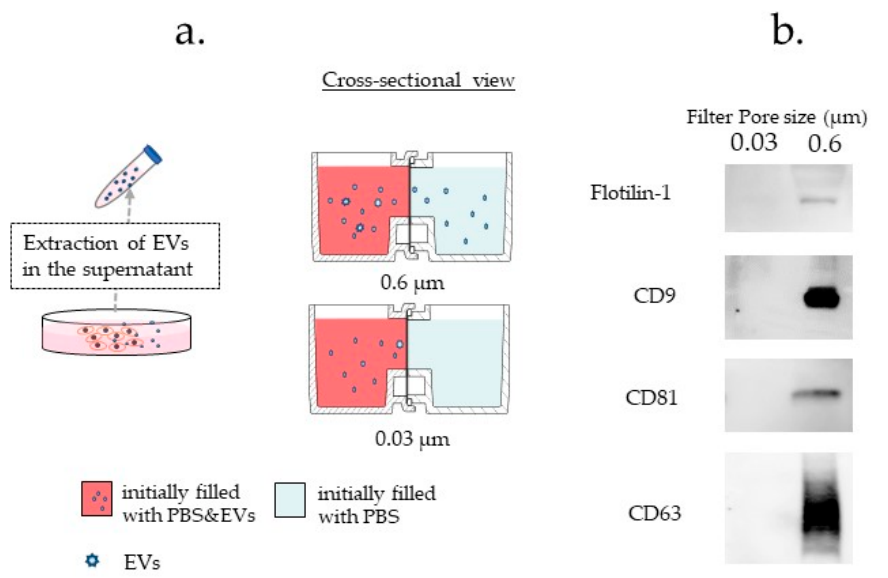
Figure 6. Validation of the ability of extracellular vesicles (EV) to pass through the filter according to pore size. ( a ) Scheme of the evaluation method for EVs secreted from PANC-1 cells. ( b ) Evaluation of the passing ability of extracellular vesicles (EVs). The same number of EVs from PANC-1 cells were seeded on one side (left side) of the horizontal-type co-culture plate (HTCP). The number of exosomes passing through the filter on the vessel’s right side were measured using Western blot. The 0.03 μ m filter blocked the transfer of the EVs. The absence of the exosome on the adjacent vessel is confirmed by the Western blotting method in experiments with pore size 0.03 μ m. Markers of exosomes (CD9, CD63, CD81, Flotilin-1) were not detected at 72 h.